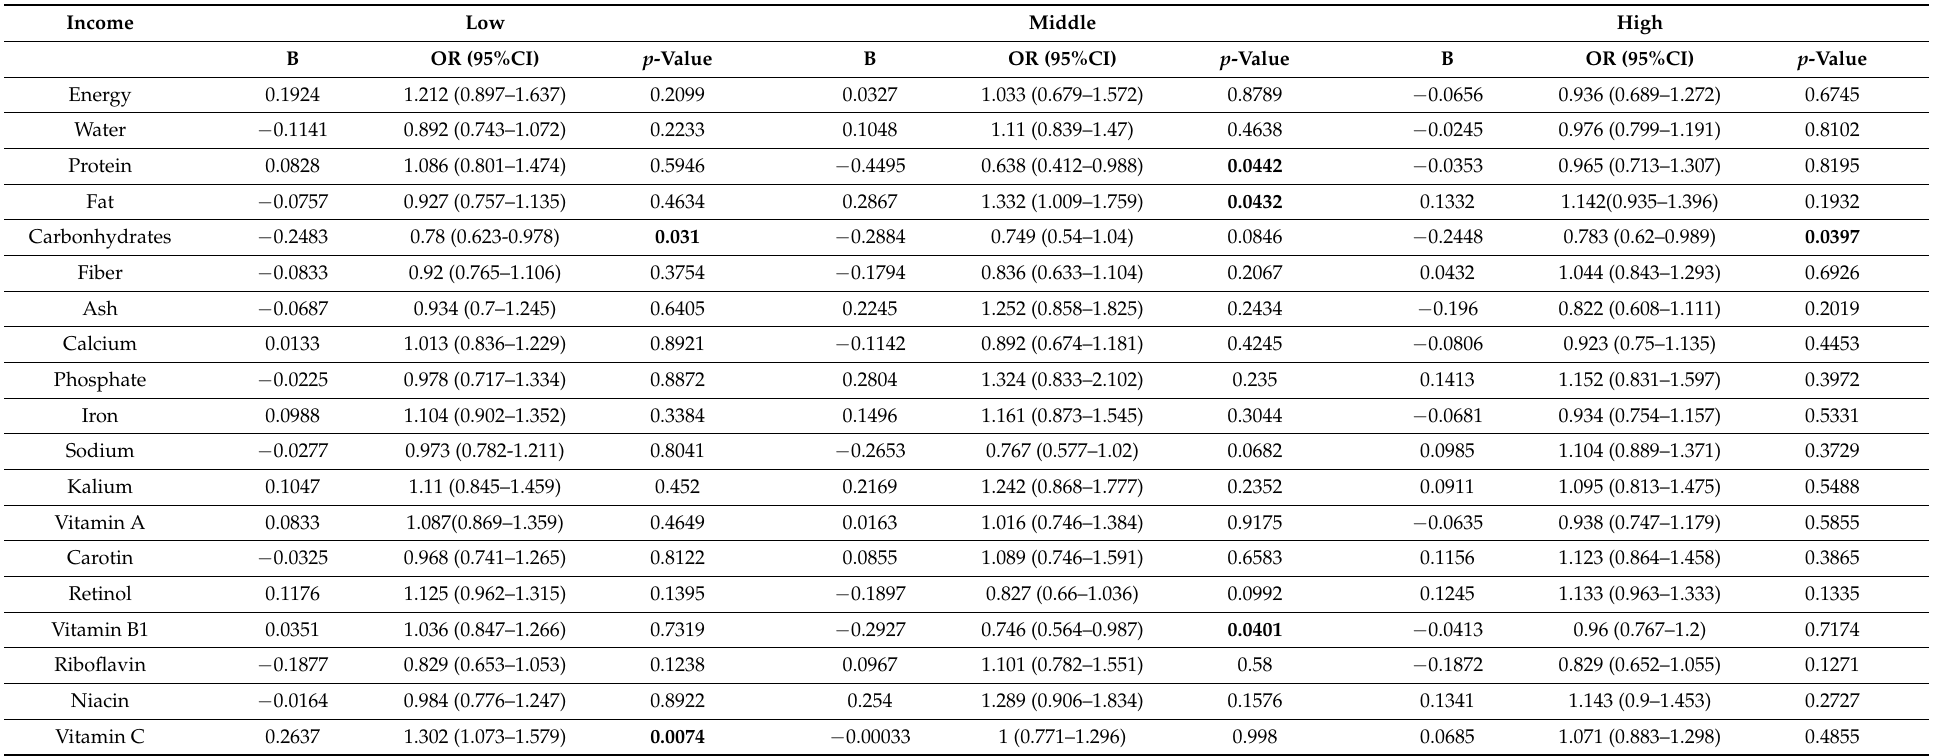
Table 7. Differences in nutritional intake between normal hearing and hearing loss according to amount of income (multiple